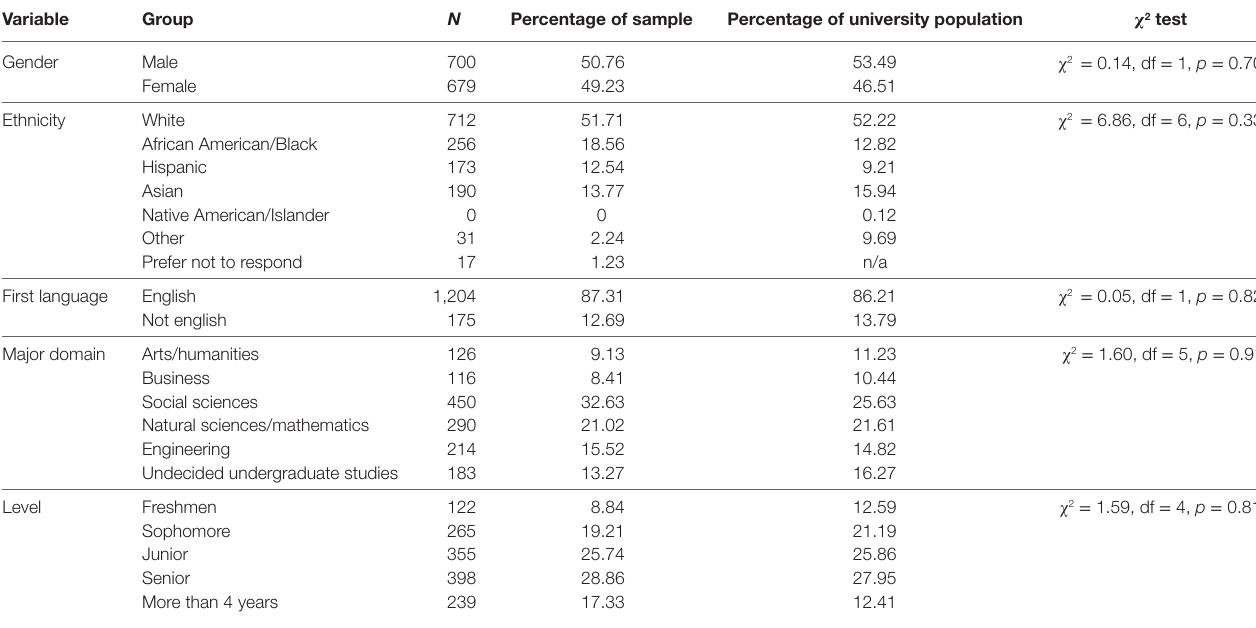
taBlE 1 | Demographics and representativeness of